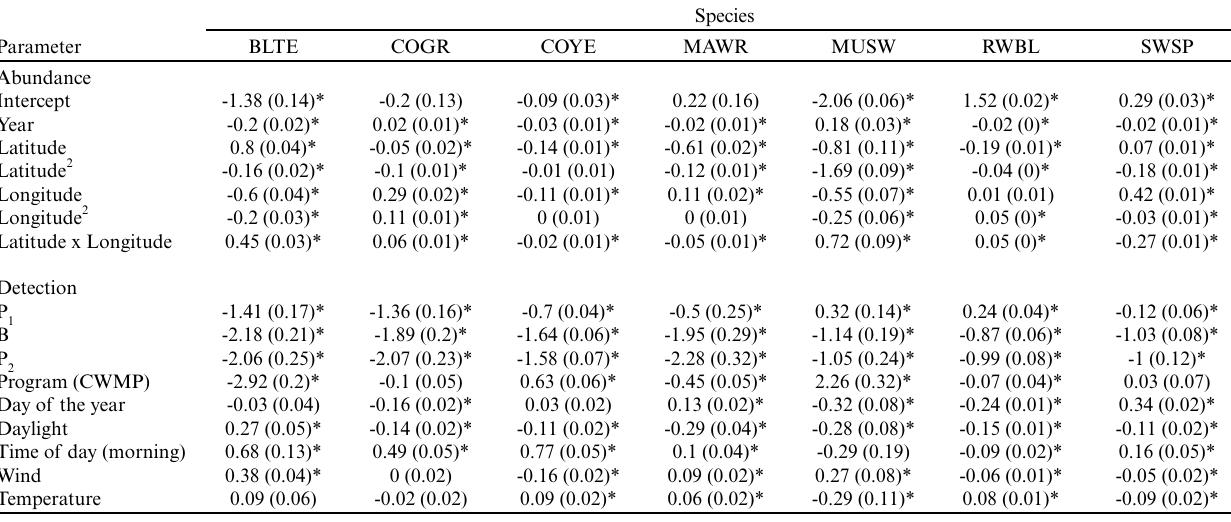
Table 2 . Parameter estimates from multinomial N -mixture models used to assess the influence of call broadcast timing within point counts and survey duration on detection probability of marsh breeding birds throughout the Great Lakes–St. Lawrence region, 2008– 2016. Standard error is given below each estimate in parentheses, with an asterisk indicating statistical significance at P < 0.05. P first 5-min passive observation period consisting of min 1–5, B = 5-min broadcast period consisting of min 6–10, P passive observation period consisting of min 11–15, CWMP = Coastal Wetland Monitoring Program, BLTE = Black Tern ( Chlidonias niger ), COGR = Common Grackle ( Quiscalus quiscula ), COYE = Common Yellowthroat ( Geothlypis trichas ), MAWR = Marsh Wren ( Cistothorus palustris ), MUSW = Mute Swan( Cygnus olor ), RWBL = Red-winged Blackbird ( Agelaius phoeniceus ), SWSP = Swamp Sparrow ( Melospiza georgiana